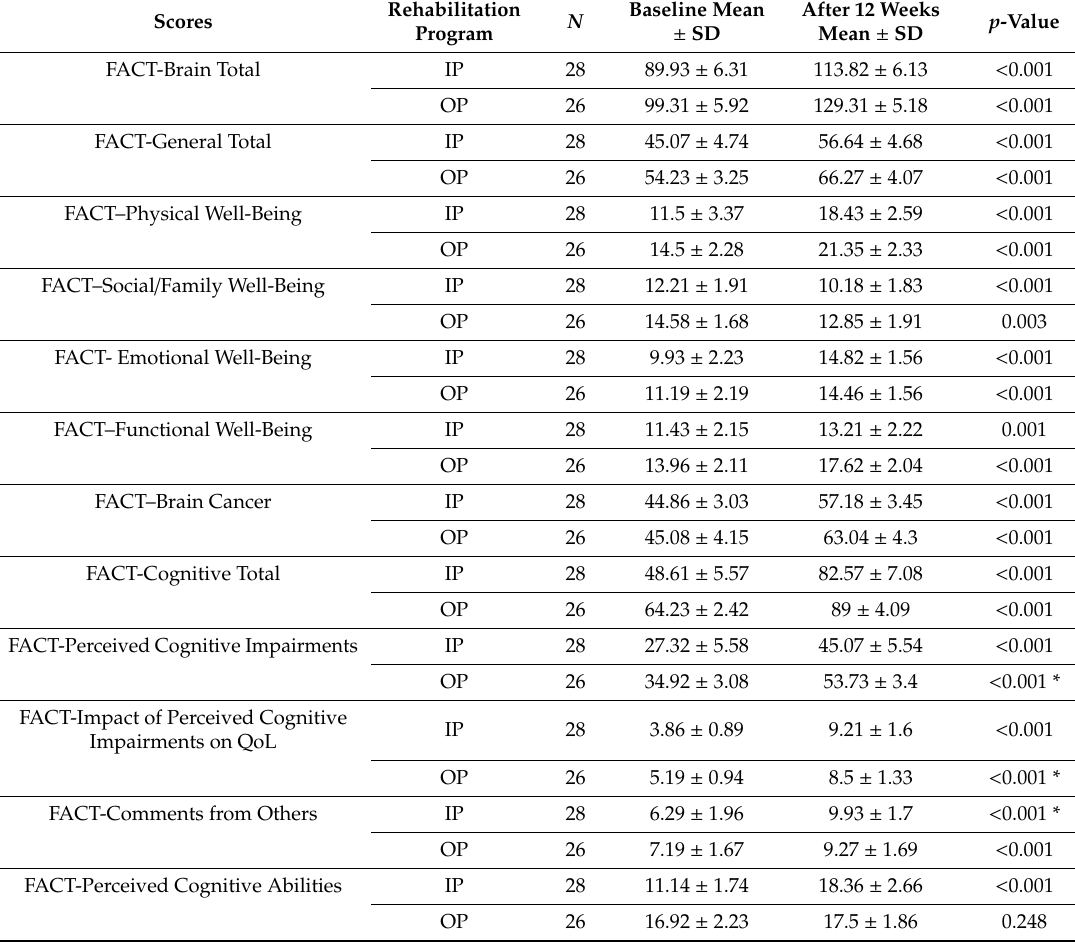
Table 5. Analysis of the patient-reported function questionnaire results before and after rehabilitation treatment in BT inpatients and